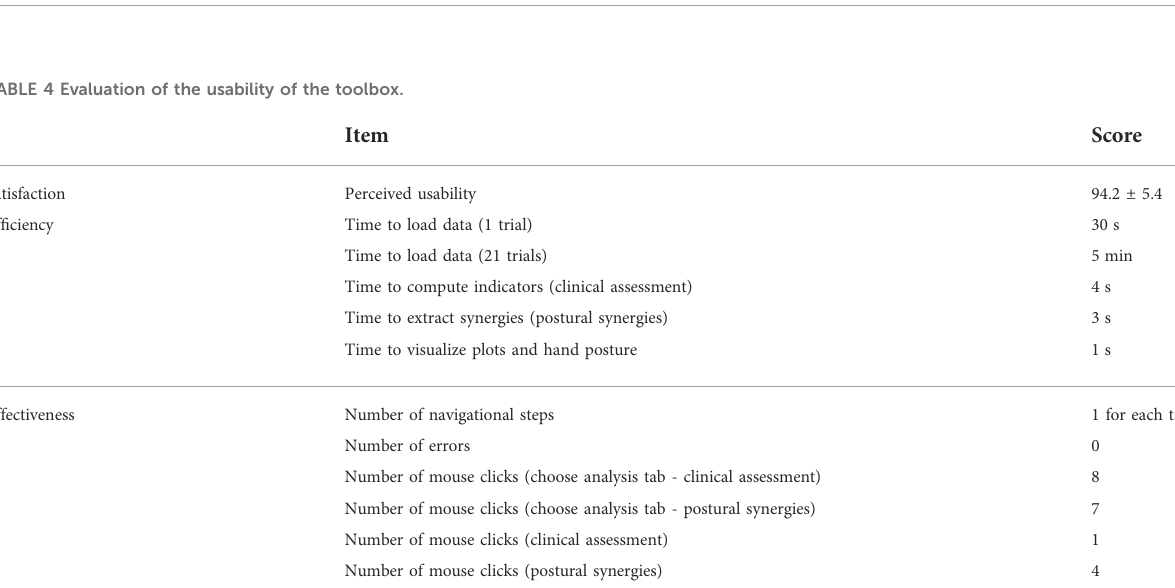
TABLE 4 Evaluation of the usability of the